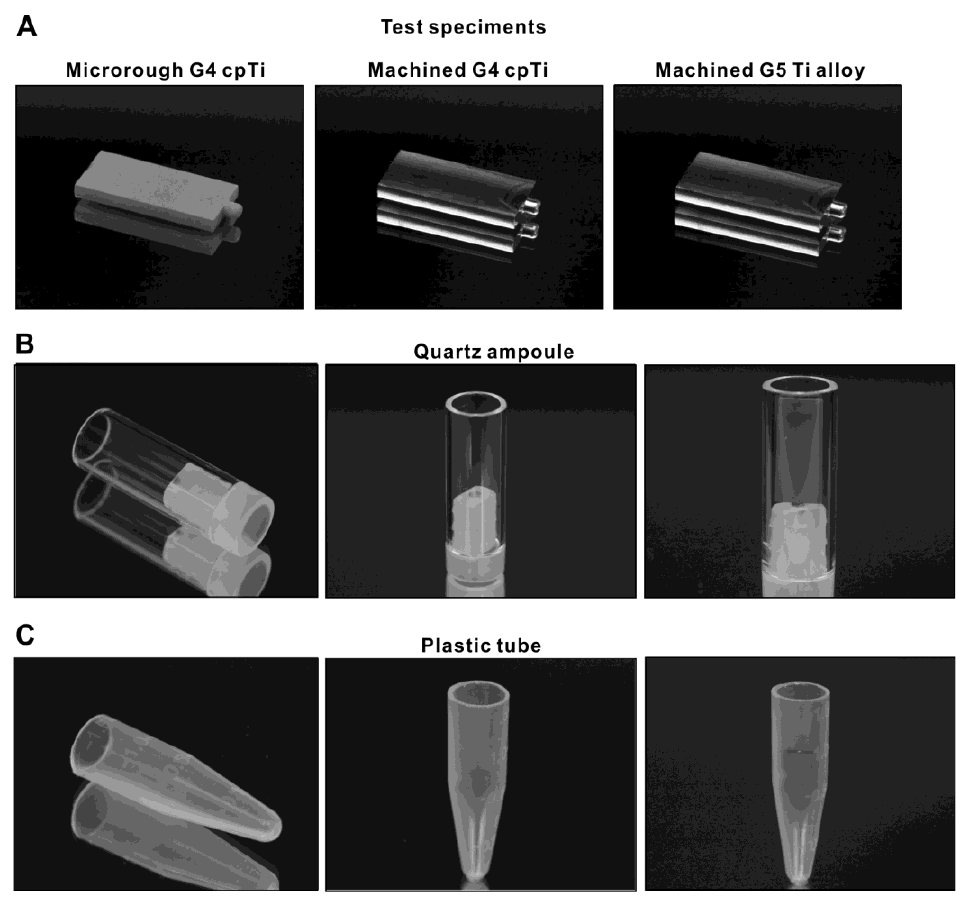
Figure 10. The titanium specimens and containers used in this study. ( A ) Test specimens made of different materials and surface topographies. ( B ) An ampoule made of synthetic quartz. A titanium specimen is placed in the quartz ampoule ( right panel). ( C ) A laboratory-grade clear plastic tube. A titanium specimen is placed in the plastic tube ( right panel).